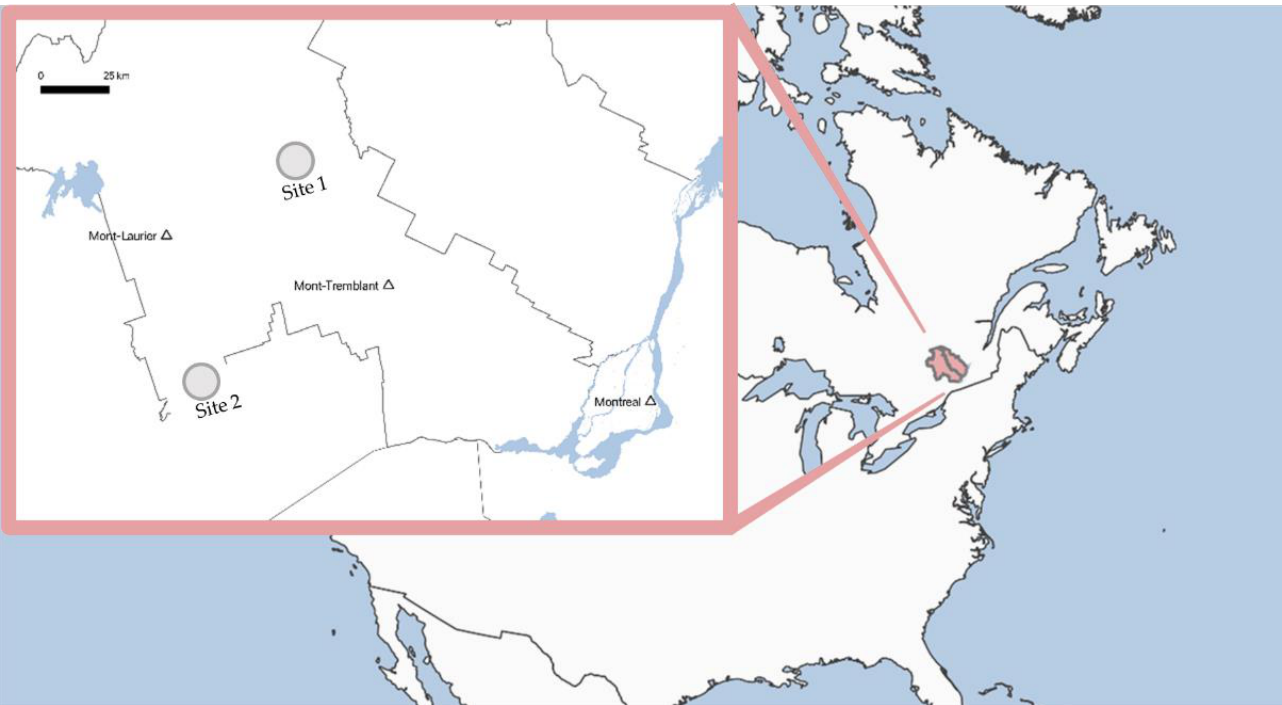
Figure 1. Location of the two study sites. Both sites are to the northwest of Montreal in the Laurentians region (Quebec, Canada).